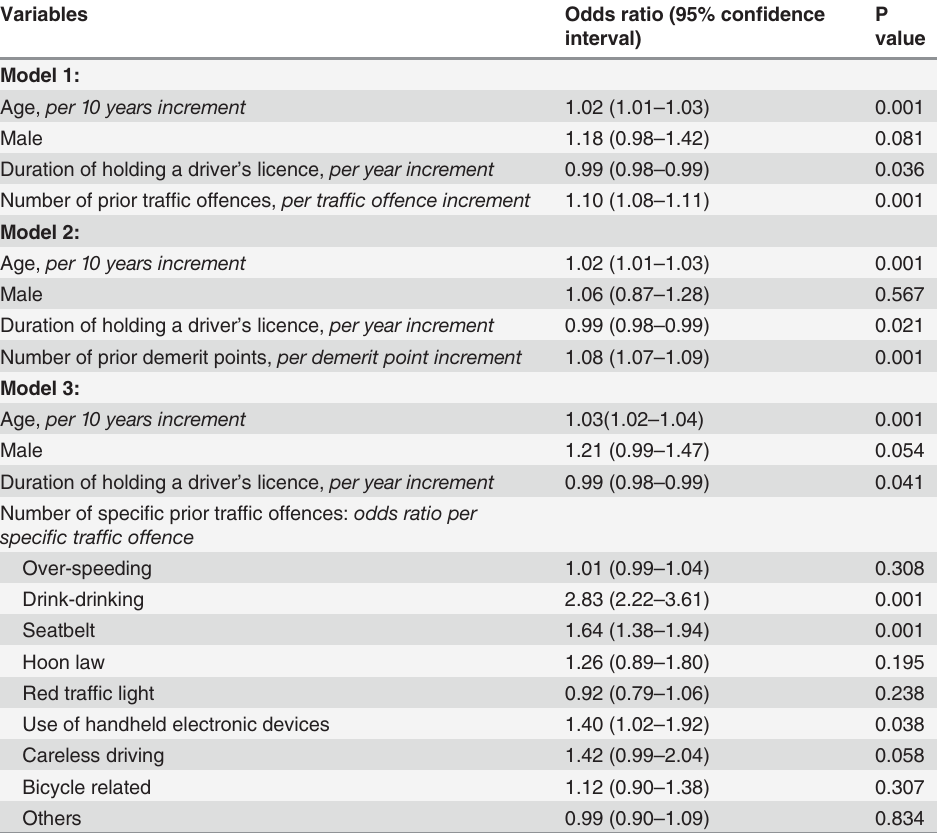
Table 2. Relationships between cumulative number of prior traffic offences, demerit points, or specif- ic types of traffic offences of a licenced motorcycle rider or motor vehicle driver and risk of road trau- ma leading to intensive care admission or death (n = 1020, N =